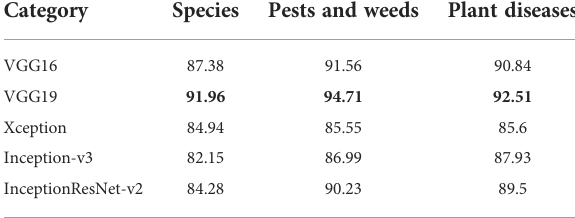
TABLE 6 Categorical macro-average test accuracy.